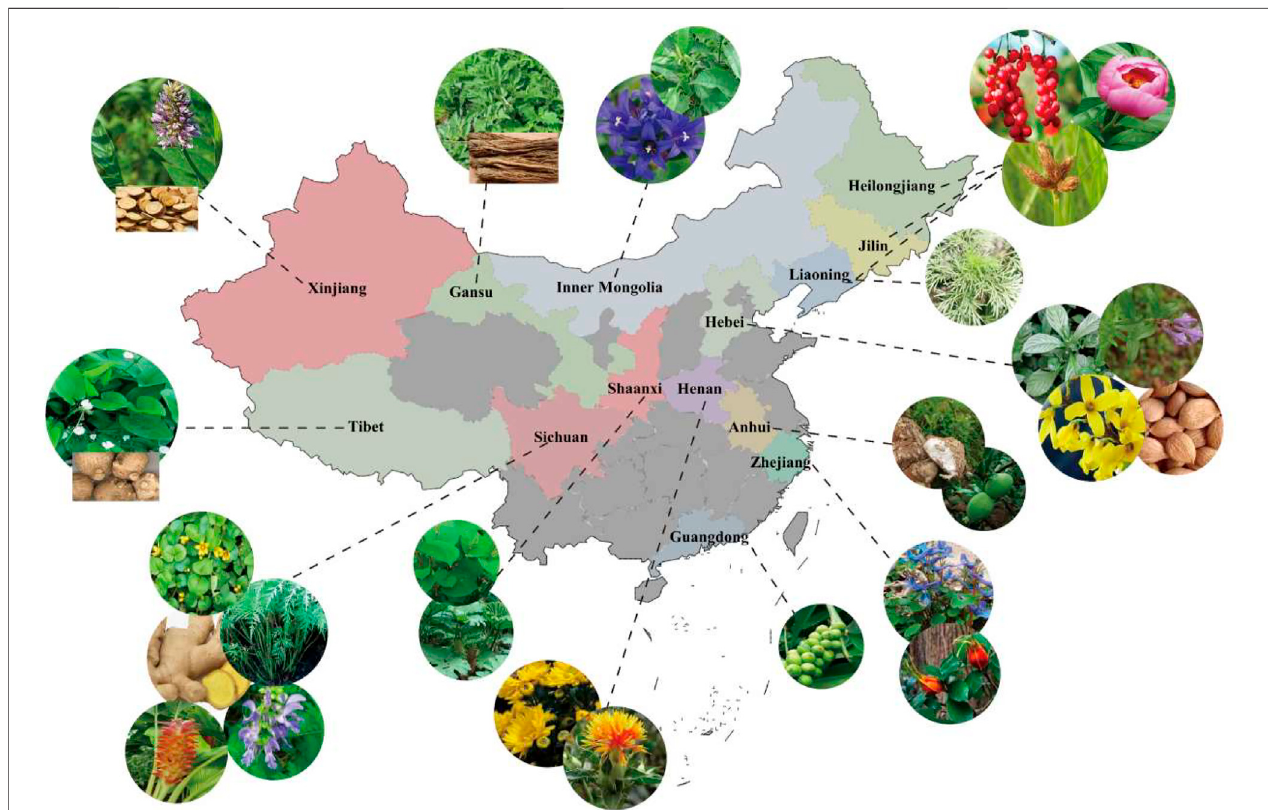
FIGURE 2 | Distribution of some Chinese medicine for liver diseases in main producing areas (also named “ Daodi ” producing area). Shaanxi: Rheum palmatum L., Polygonum cuspidatum Sieb.et Zucc.; Sichuan: Salvia miltiorrhiza Bunge., Zingiber of fi cinale Rosc., Ligusticum chuanxiong Hort., Curcuma wenyujin Y. H. Chen et C. Ling, Lysimachia christinae Hance; Gansu: Angelica sinensis (Oliv.) Diels; Tibet: Alisma orientalis (Sam.) Juzep.; Hebei: Prunus persica (L.) Batsch, Forsythia suspensa (Thunb.) Vahl, Isatis indigotica Fort., Scutellaria baicalensis Georgi; Henan: Carthamus tinctorius L., Chrysanthemum morifolium Ramat.; Zhejiang: